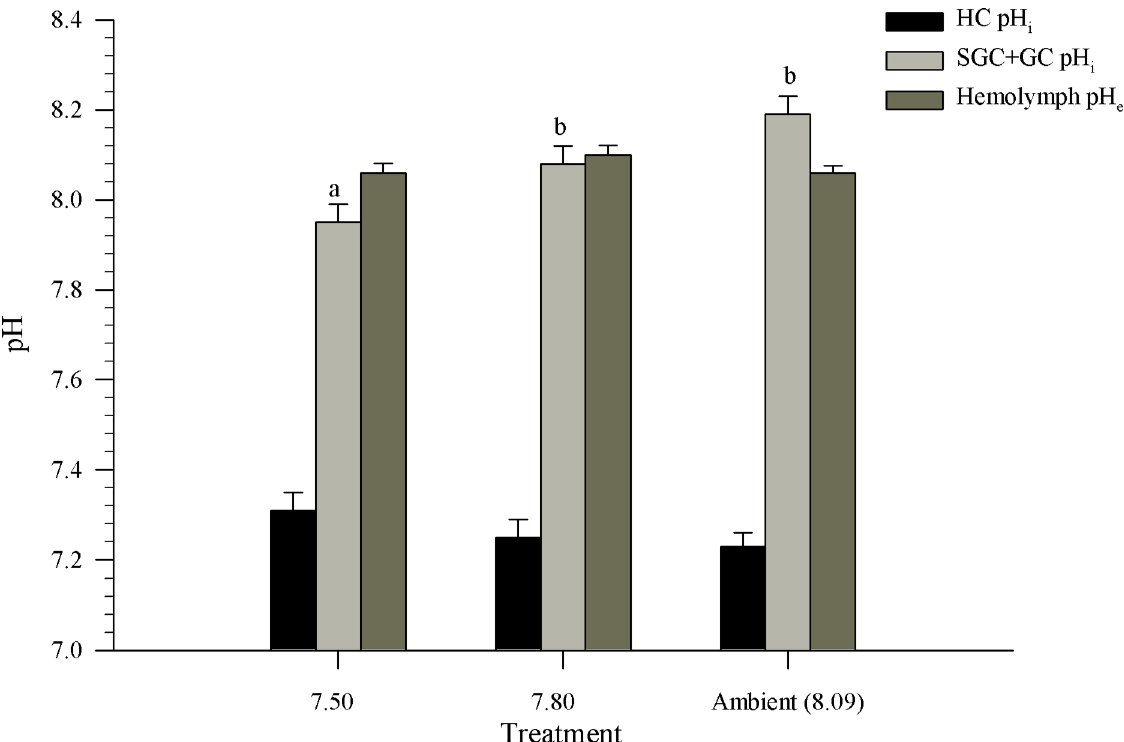
Fig 5. Hemolymph pH (pH e ) and intracellular pH (pH i ) for semi-granular+granular cells (SGC+GC) and hyalinocyte cells (HC) from Chionoecetes bairdi , Tanner crab. The error bars represent the standard error and letters indicate significant differences between